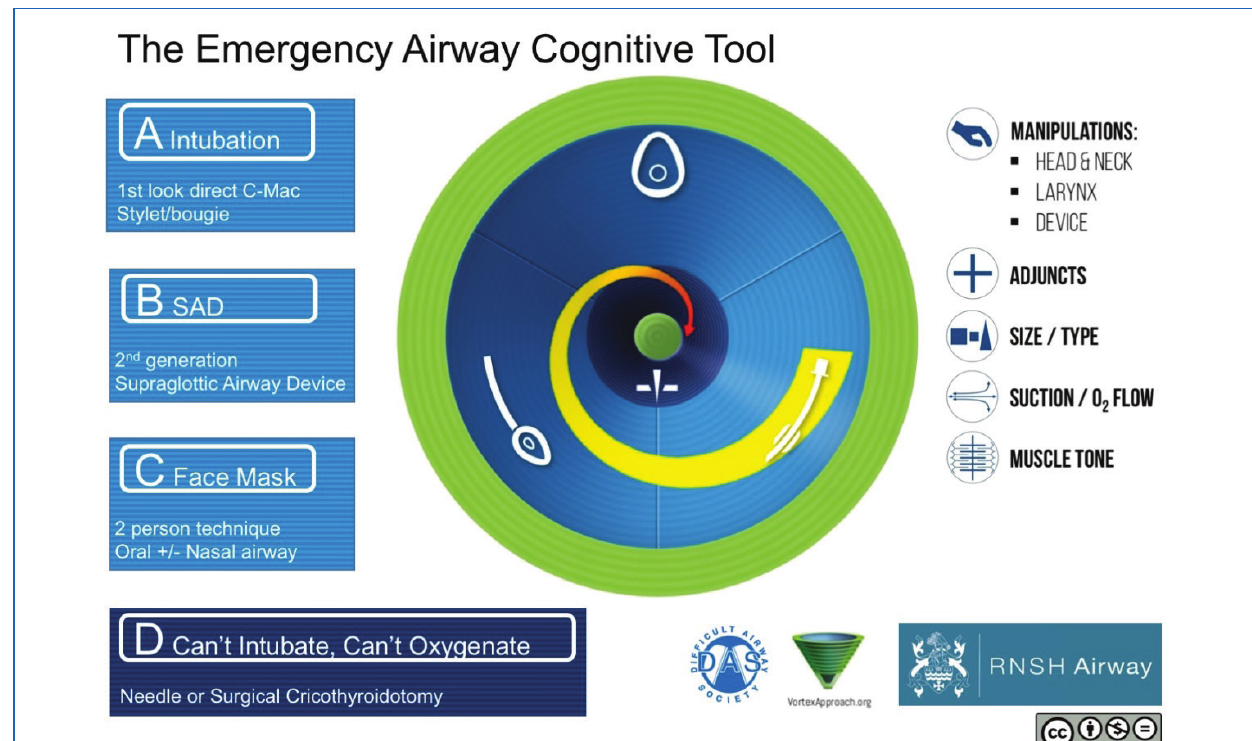
Figure 2. Vortex implementation tool (superior and lateral aspects) Green zone – adequate alveolar oxygen delivery